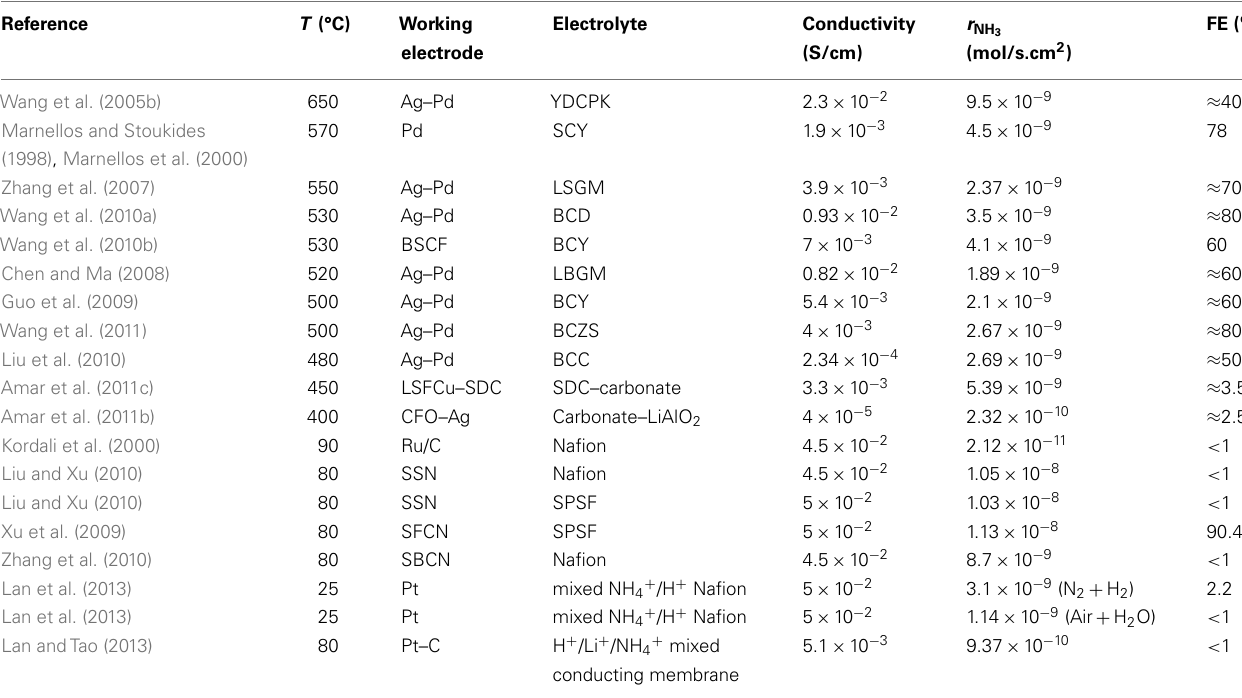
Table 3 | Reaction rates and Faradaic